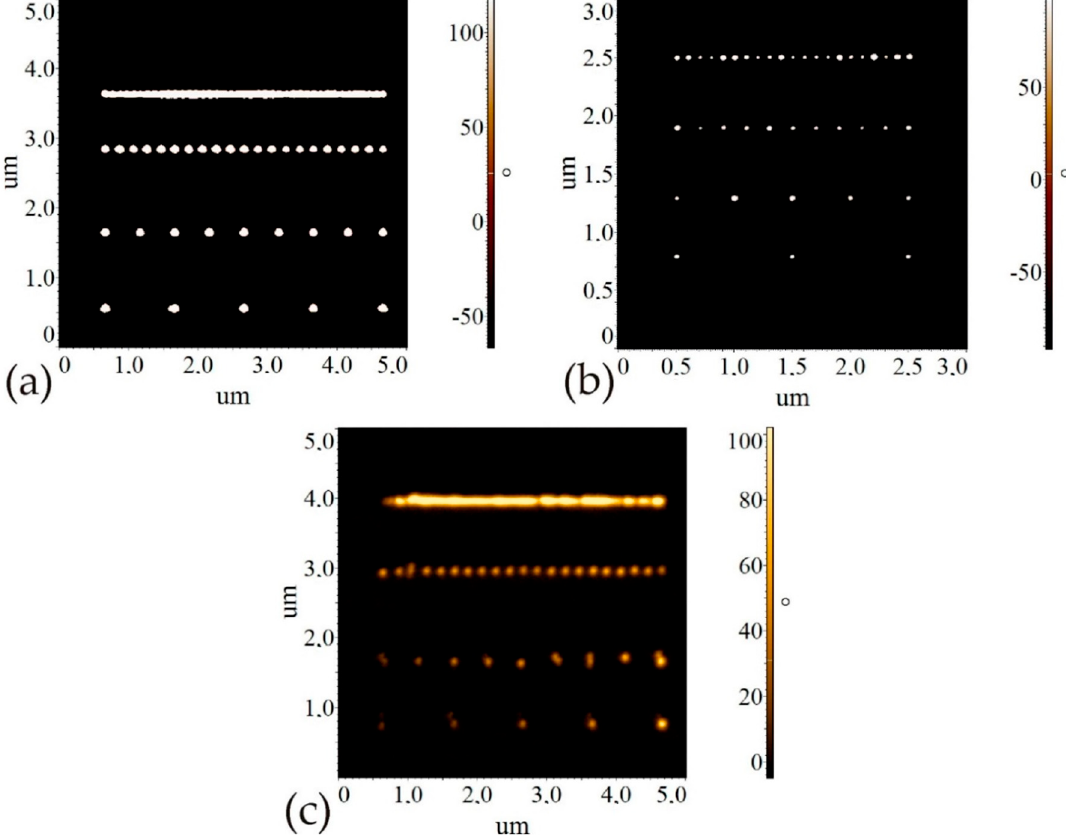
Figure 2. PFM images of the domain panels observed under different conditions of AFM-tip writing.